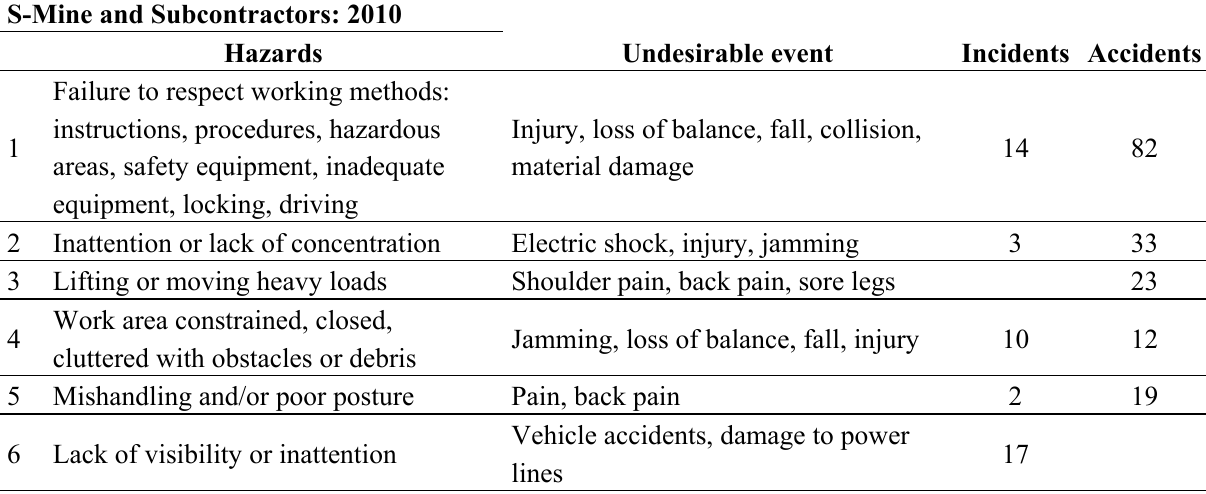
Table 2. Analysis of incidents and accidents (S-Mine and Subcontractors,